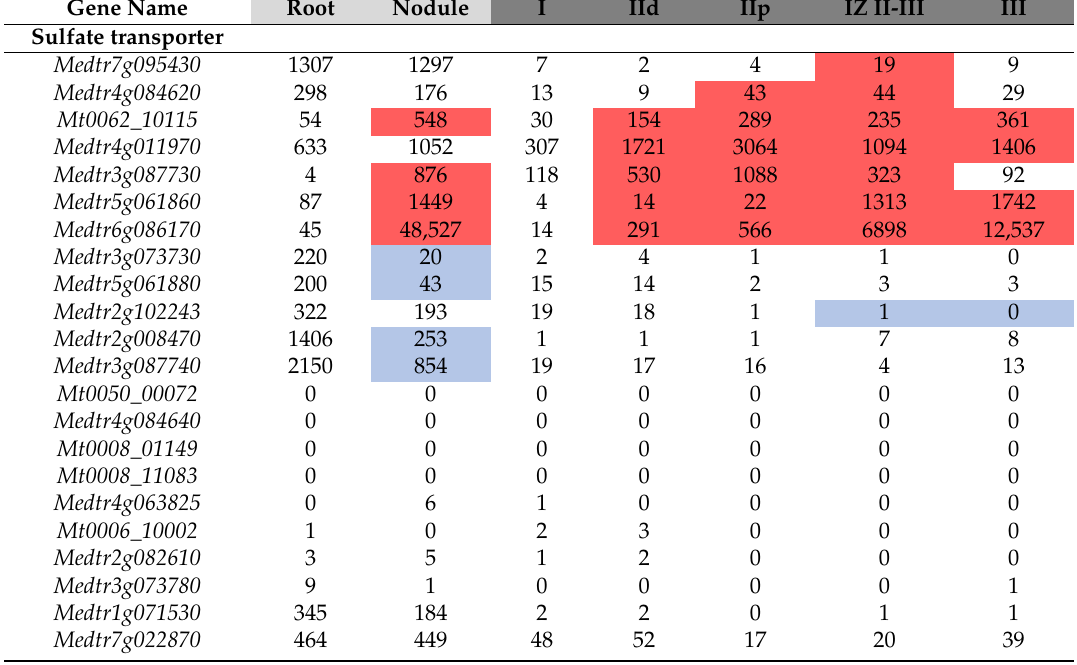
Table 1. Expression of plant sulfate transporters in M. truncatula nodules. Gene accession numbers are indicated in the table. Gene annotation is based on candidate orthologs and interprodomain signature. The different columns correspond to root and nodule whole organ analysis (Root and Nodule) and to the nodule zones: meristematic zone (I), distal infection zone (IId), proximal infection zone (IIp), infection/fixation interzone (IZ II-III), and nitrogen-fixation zone (III). The numbers in the different columns correspond to Total Reads RiboMinus ™ rRNA depletion. All RNA-seq read values were normalized [50]. The total reads are reported from the symbimics bioinformatics website. The full organs are nitrogen starved Roots and 10-day old nodules. The red and blue colors correspond, respectively, to higher and lower significant differences between the organs (roots and nodules) and between the different nodule zones. The statistical differences are reported from the symbimics bioinformatics website.